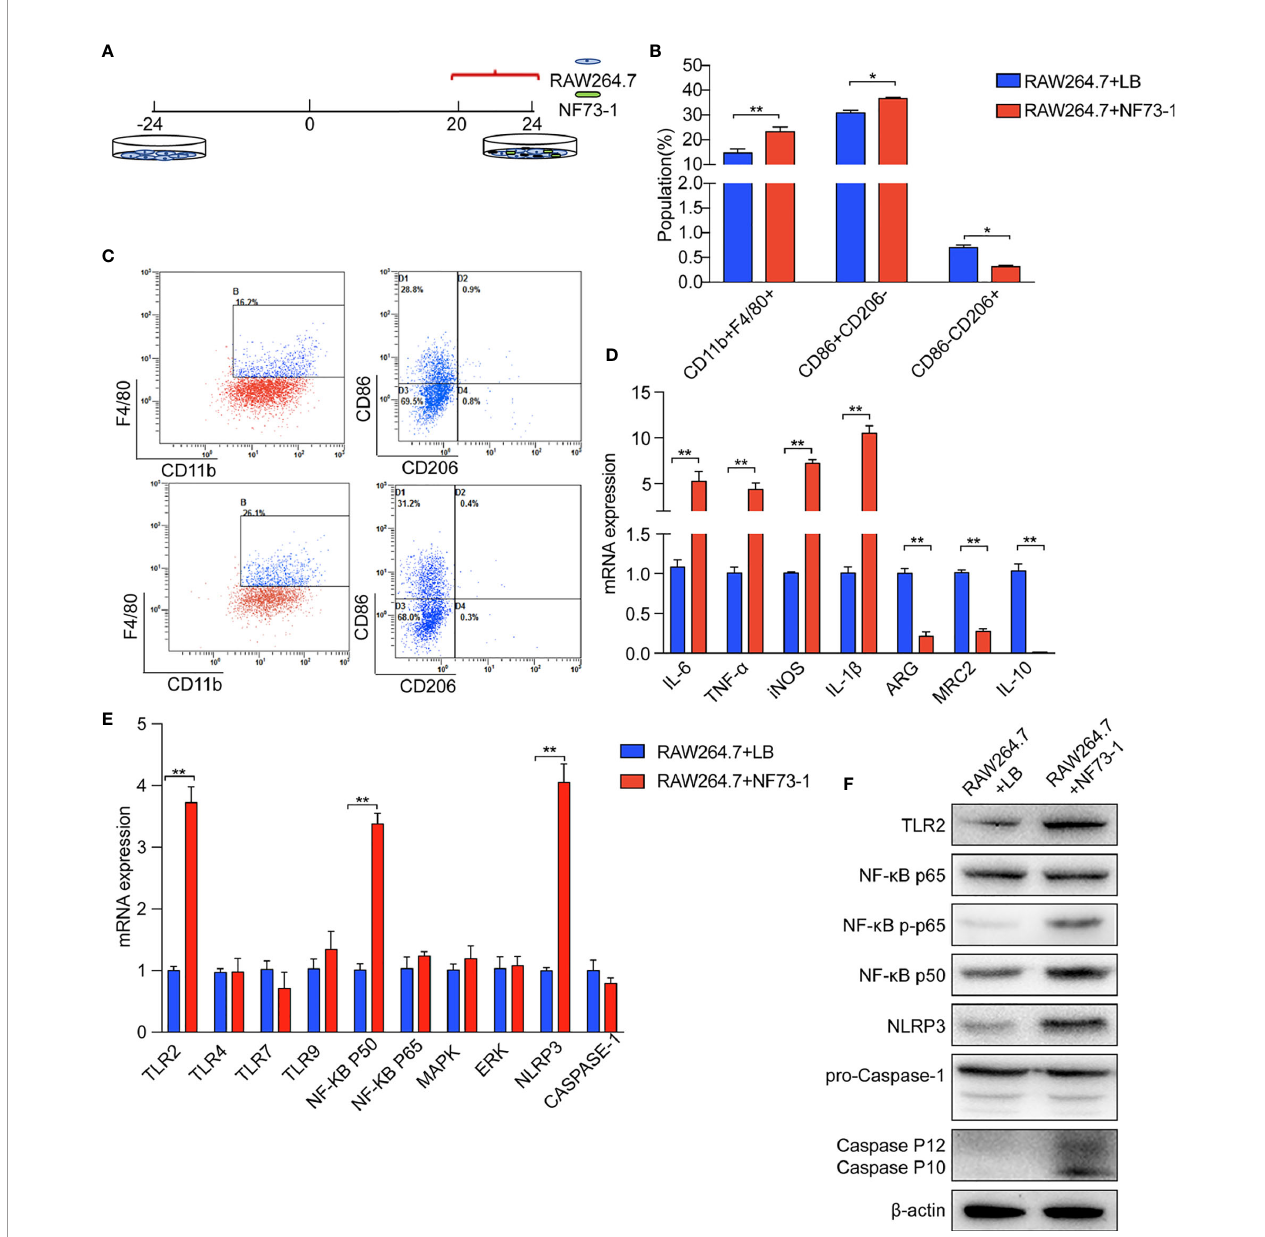
FIGURE 6 | E. coli NF73-1, the inducer of M1 macrophage polarization. (A) RAW264.7 cells exposed to E. coli NF73-1 (multiplicity of infection = 1:10) for 4 h. (B) Effects of E. coli NF73-1 on the expression of CD11b, F4/80, CD86, and CD206 in RAW264.7 cells. RAW264.7 cells were cultured with palmitic acid and oleic acid for 20 h without E. coli NF73-1. (C) Representative fl ow plots. (D) cDNA expression of M1 and M2 markers after coculture with RAW264.7 and E. coli NF73-1 cells. (E) mRNA expression in RAW264.7 cells. (F) Protein synthesis in RAW264.7 cells. Data are calculated as the mean ± SEM, *p <0.05, **p <0.01 (unpaired t test). TNF- a , tumor necrosis factor a ; IL-6, interleukin 6; IL-1 b , interleukin 1 b ; iNOS, inducible nitric oxide synthase; Arg, arginase; Mrc2, macrophage mannose receptor 2, IL-10, interleukin 10; TLR, toll-like receptor; NF-KB, nuclear factor kappa-B; MAPK, mitogen-activated protein kinase; ERK, extracellular regulated protein kinases; NLRP3, Nod-like receptor pyrin domain containing